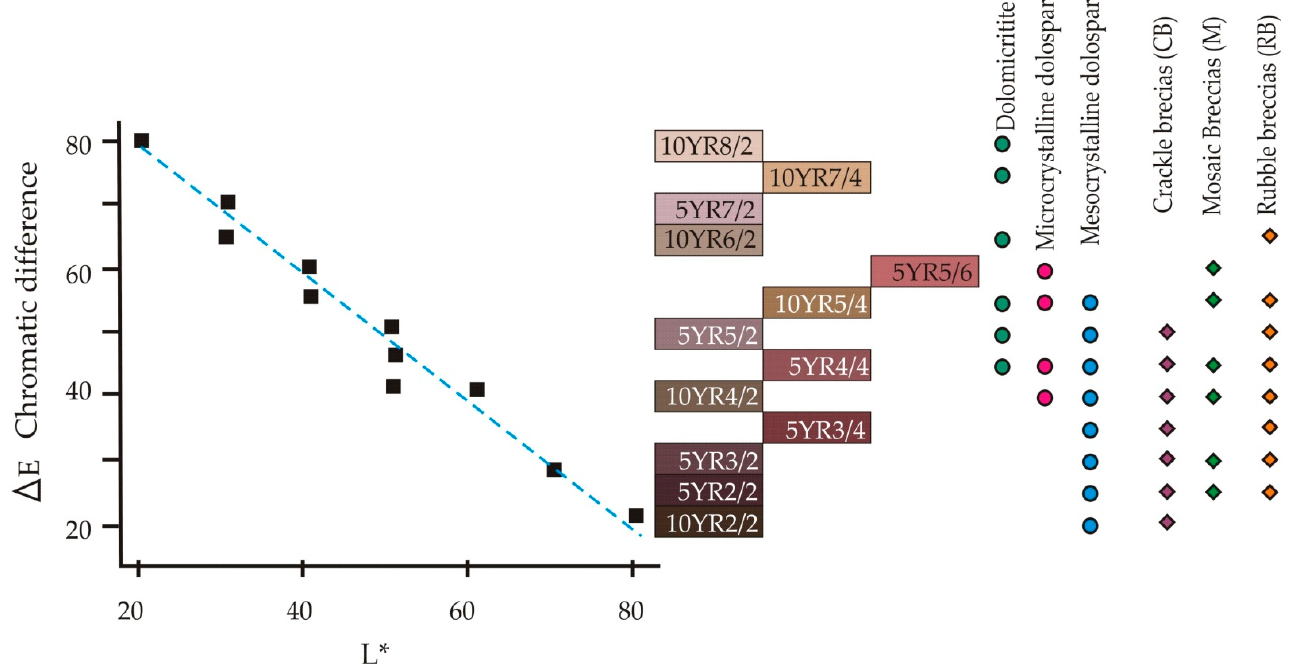
Figure 9. Correlation of colour parameters of the dolomite clast samples (Table S4, Supplementary Materials) according to Munsell and CIELab systems.